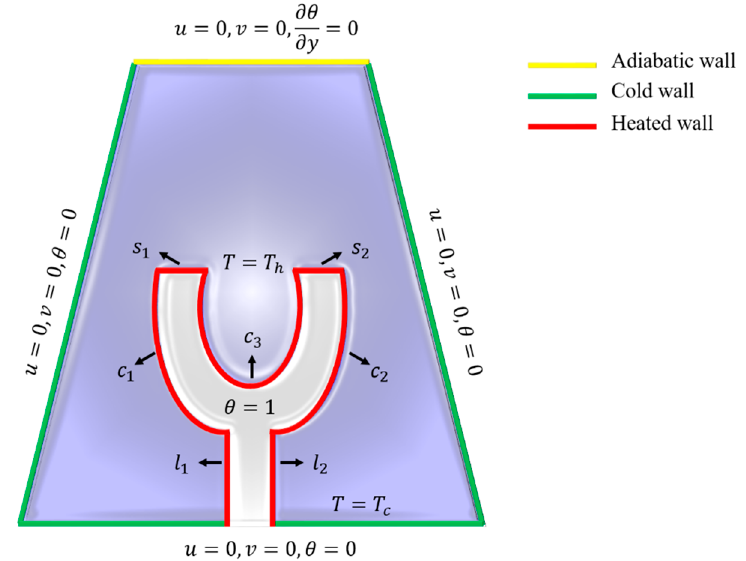
Figure 1. A diagrammatic illustration of the problem.